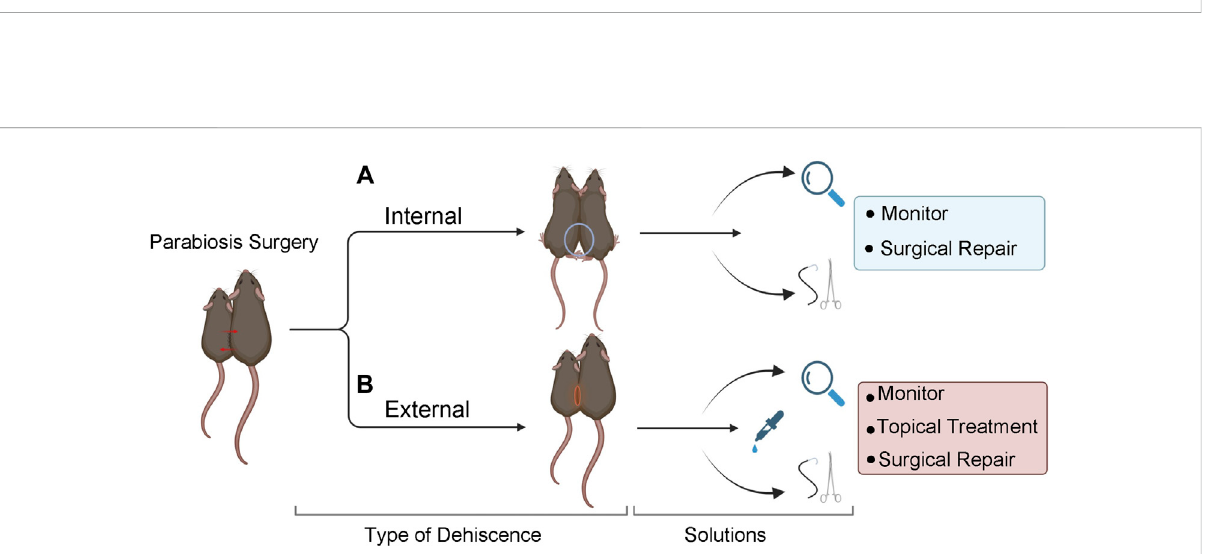
FIGURE 4 Solutions forinternalandexternal dehiscence. (A) Internal dehiscenceoccurswhenoneorbothjointunionshave separated. Useadoubleknot technique at the time of surgery to prevent dehiscence. Surgically repair elbow separation. If knee separation occurs, observe or surgically repair, based on the severity and/or length of time after the original surgery. (B) External dehiscence occurs when the skin separates along the suture site. Treat with topical agents, monitor, and/or surgically repair. If both internal and external dehiscence occur at the same time, surgical repair is